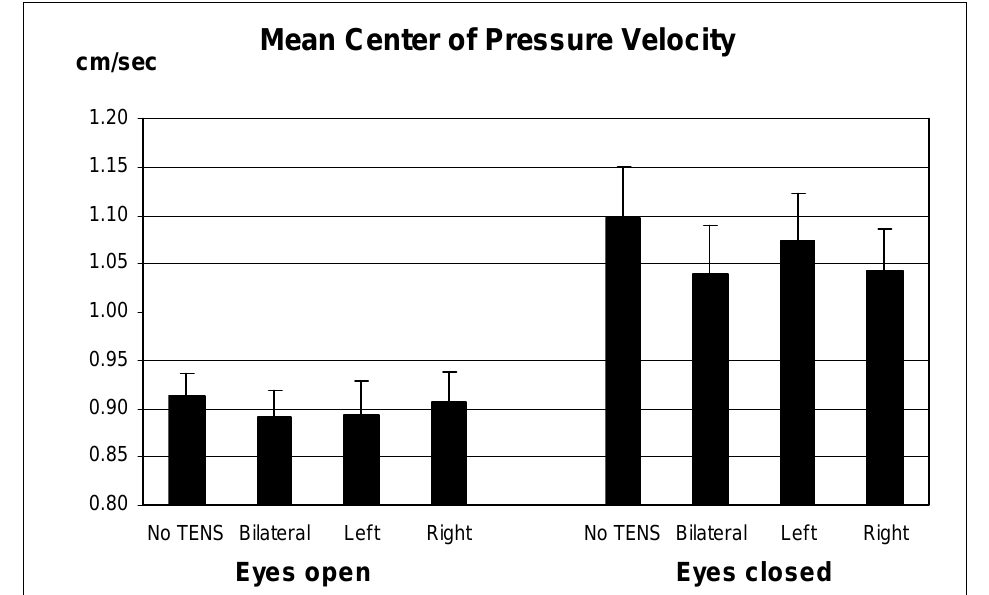
Figure 1. Mean and standard deviation of center of pressure sway velocity in each of the four TENS conditions with eyes open and eyes closed.